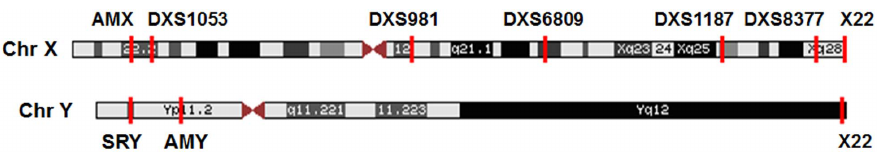
Figure 1. Graphic scheme of the chromosomal localization of the eight sex chromosomal markers used in the newly designed multiplex PCR assay. The markers were located according to Human Genome Browser – hg38